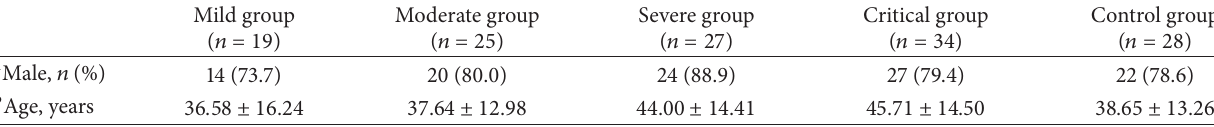
Table 1: Demographic characteristics for patients with HFRS.